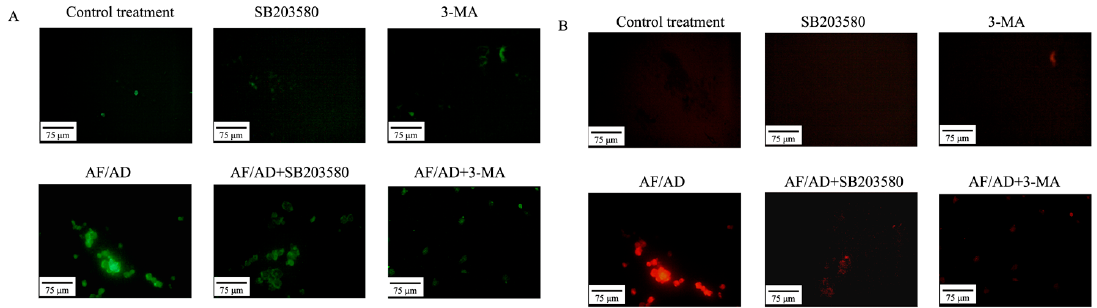
Figure 4. Effect of AF/AD on Beclin-1 and LC3, respectively, with or without SB203580 or 3-MA in Bel-7402 cells analyzed by immunofluorescence assay. Bel-7402 cells were pretreated with AF (6 μ M)/ AD (20 μ M) in the absence or presence of SB203580 (10 μ M) or 3-MA (5 mM) for 24 h. Expression of Beclin-1 ( A ) and LC3 ( B ) were analyzed by immunofluorescence assay.